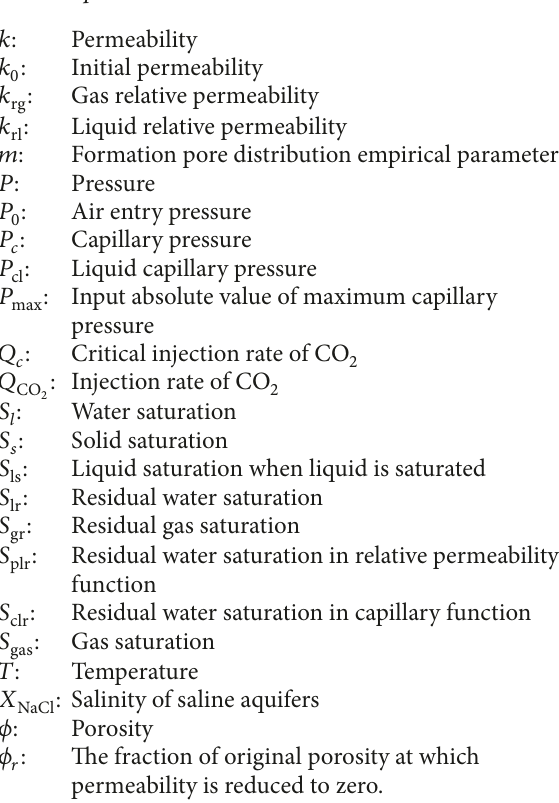
values and 𝑆 𝑠 CO 2